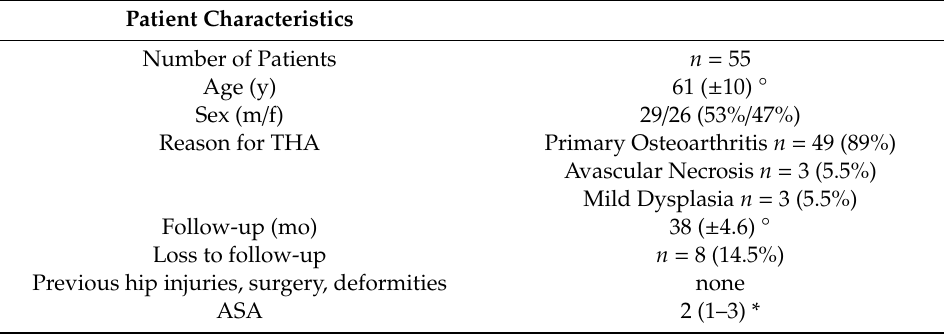
Table 1. Patient characteristics. Values are depicted as absolute numbers and percentage unless marked otherwise. ◦ values depicted as mean and standard deviation, * values depicted as median and